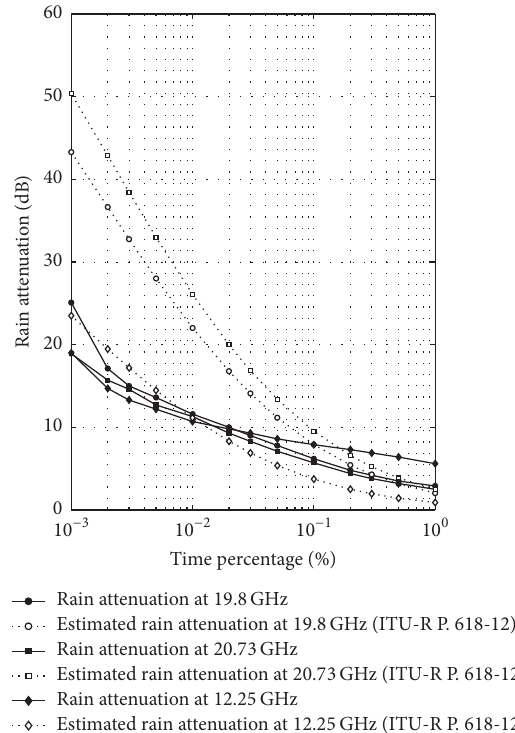
Figure 5: Cumulative distribution of rain attenuation as compared with ITU-R P. 618-12